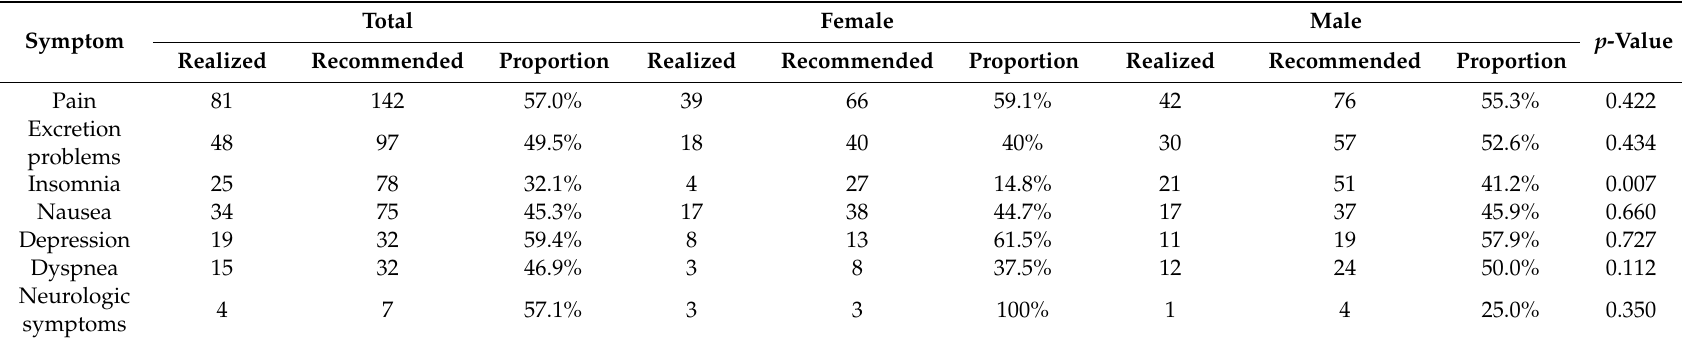
Table 2. Analysis of recommendations and the realized implementation of drug conversions for inpatients (subgroup analysis, n = 490 *). Comparison of realization of recommendations between males and females for the respective symptom expressed by p -value of χ 2